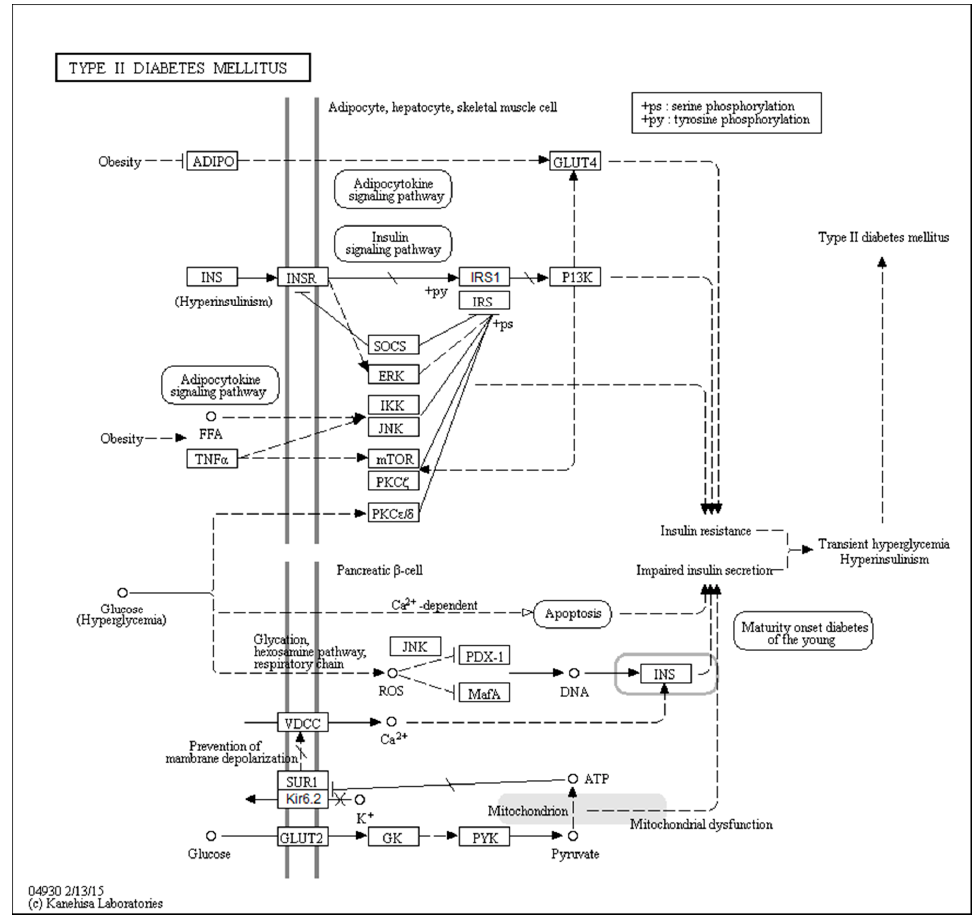
Figure 1. KEGG-based protein–protein interaction network of proteins related to the T2DM pathogenesis (hsa04930). Proteins listed in this network include adiponectin (ADIPO), insulin (INS), insulin receptor (INSR), suppressors of cytokine signaling (SOCS), extracellular signal-regulated kinase 2 (ERK), inhibitor of nuclear factor κ -B kinase (IKK), c-Jun N-terminal kinase (JNK), tumor necrosis factor α (TNF α ), mammalian target of rapamycin (mTOR), protein kinase C ξ type (PKC ξ ), protein kinase C ε / δ type (PKC ε / δ ), insulin receptor substrate 1 (IRS1), insulin receptor substrate (IRS), phosphatidylinositol 3-kinase (P13K), voltage-dependent L-type calcium channel subunit α -1C (VDCC), sulfonylurea receptor 1 (SUR1), inward rectifier K + channel Kir6.2 (Kir6.2), glucose transporter type 2 (GLUT2), glucokinase (GK), protein-tyrosine kinase (PYK), pancreas/duodenum homeobox protein 1 (PDX-1), and MAF bZIP transcription factor A (MafA). Copyright permission from KEGG